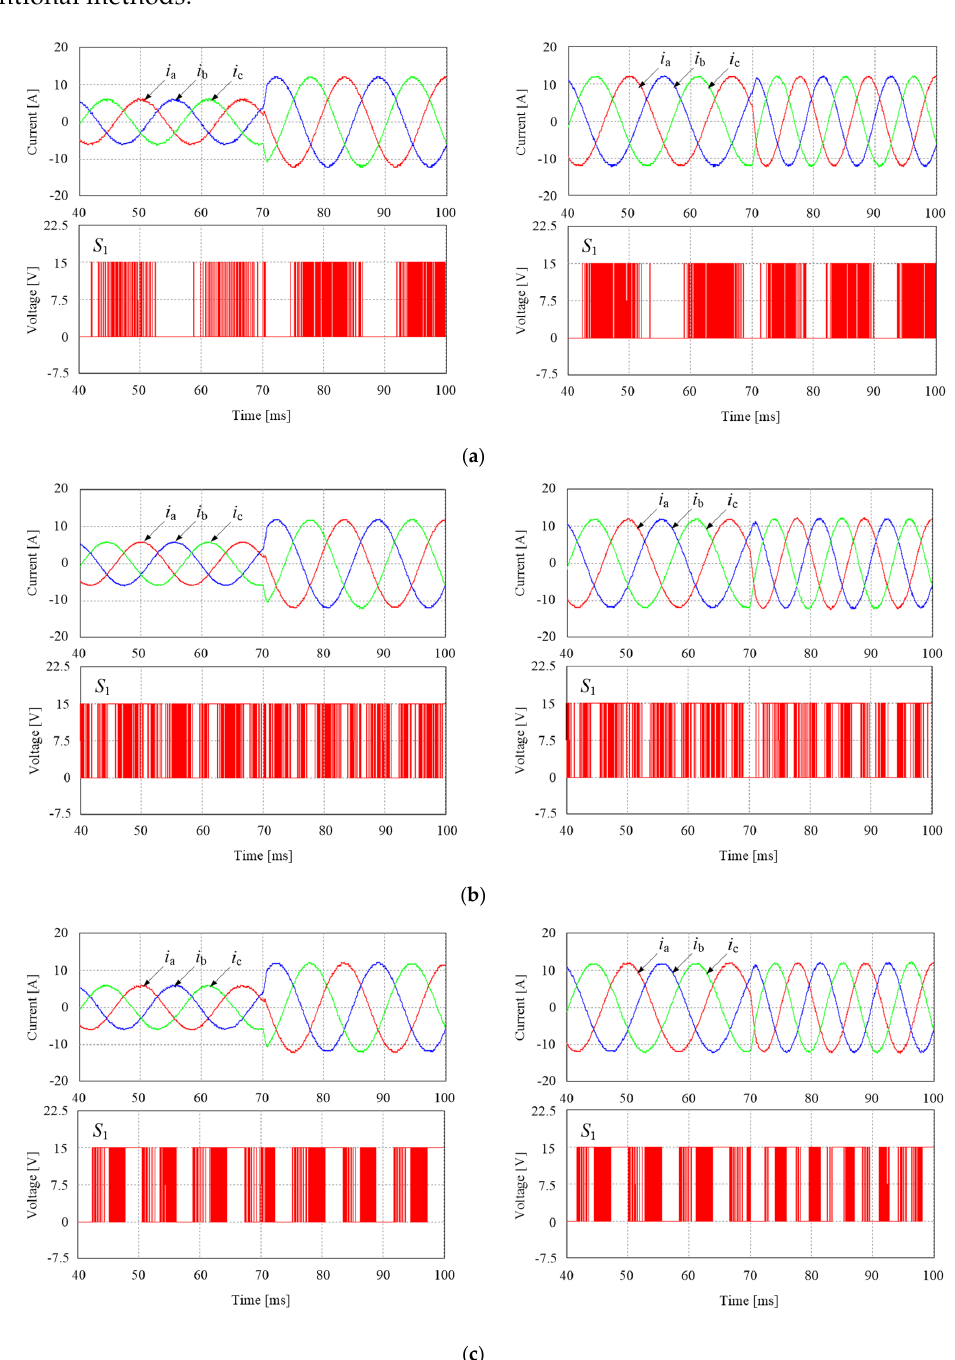
Figure 9. Simulation results of the three-phase output currents ( i a , i b , and i c ) and the a -leg upper switch S 1 for the current magnitude step change from 6 A to 12 A and frequency step change from 60 Hz to 90 Hz (| I *| = 12 A). ( a ) the conventional method using one vector, ( b ) the conventional method using two vectors, and ( c ) the proposed method with switching frequency f switching = 4 kHz .